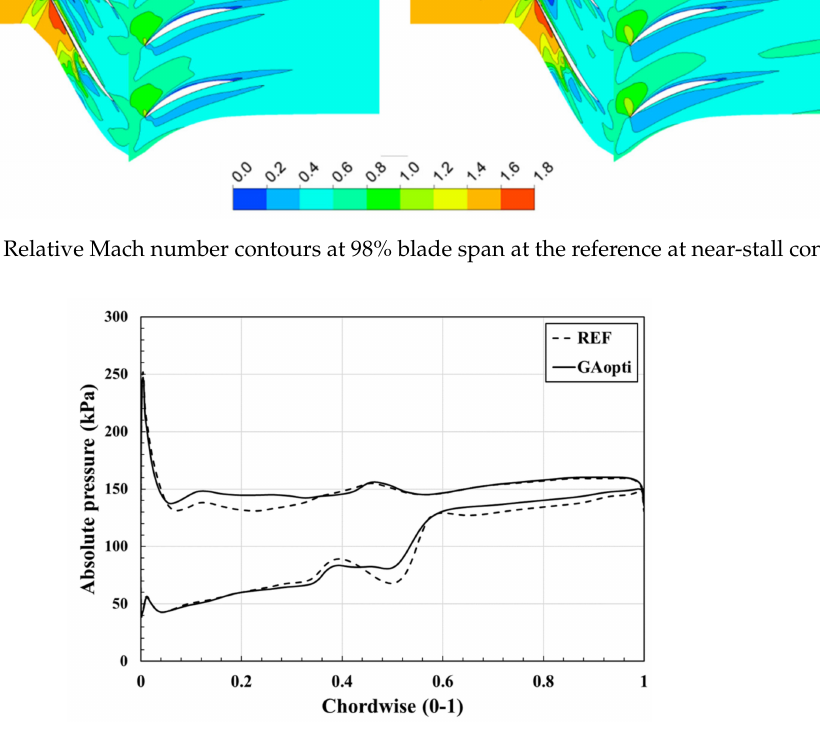
Figure 16. Rotor blade’s loading at 99% span at near-stall condition.